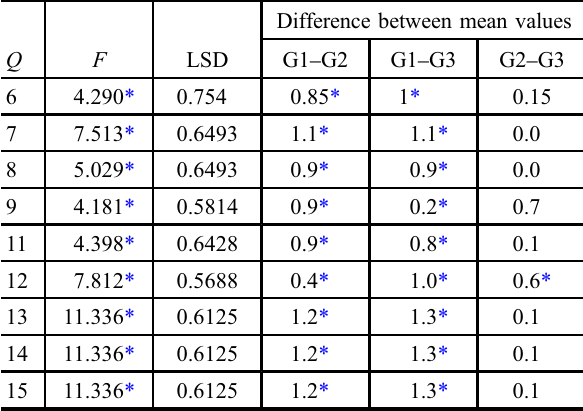
Table 6. Least significant difference test (Tukey ’ s